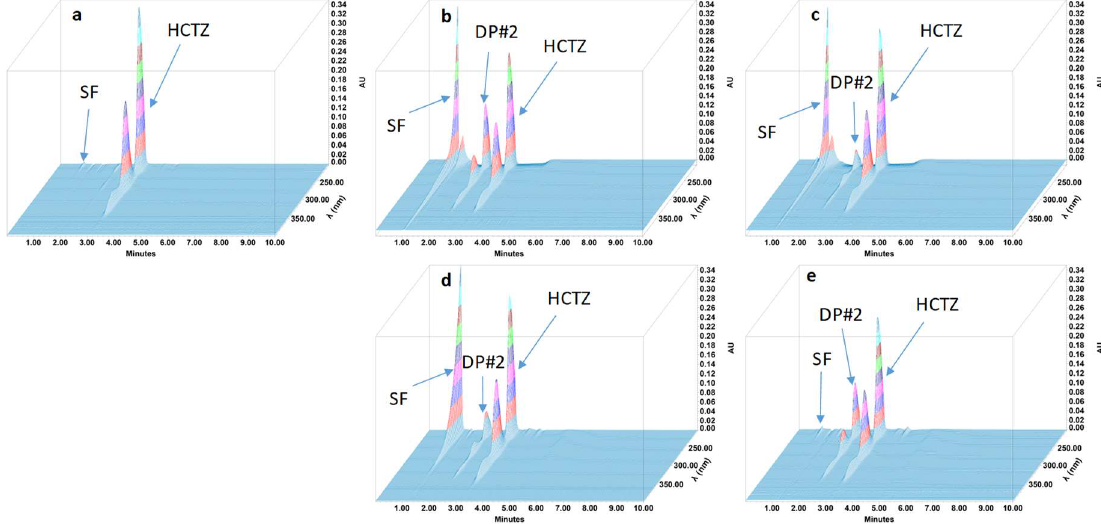
Figure 2. Three-dimensional chromatograms obtained for hydrochlorothiazide (HCTZ) oral suspensions after applying different stress conditions. ( a ) No stress; ( b ) HCl 1 M at 80 °C for 1 h; ( c ) NaOH 1 M at 80 °C for 1 h; ( d ) H 2 O 2 3% at 80 °C for 4 h; ( e ) 80 °C for 4 h. SF: solvent front; DP: degradation product.